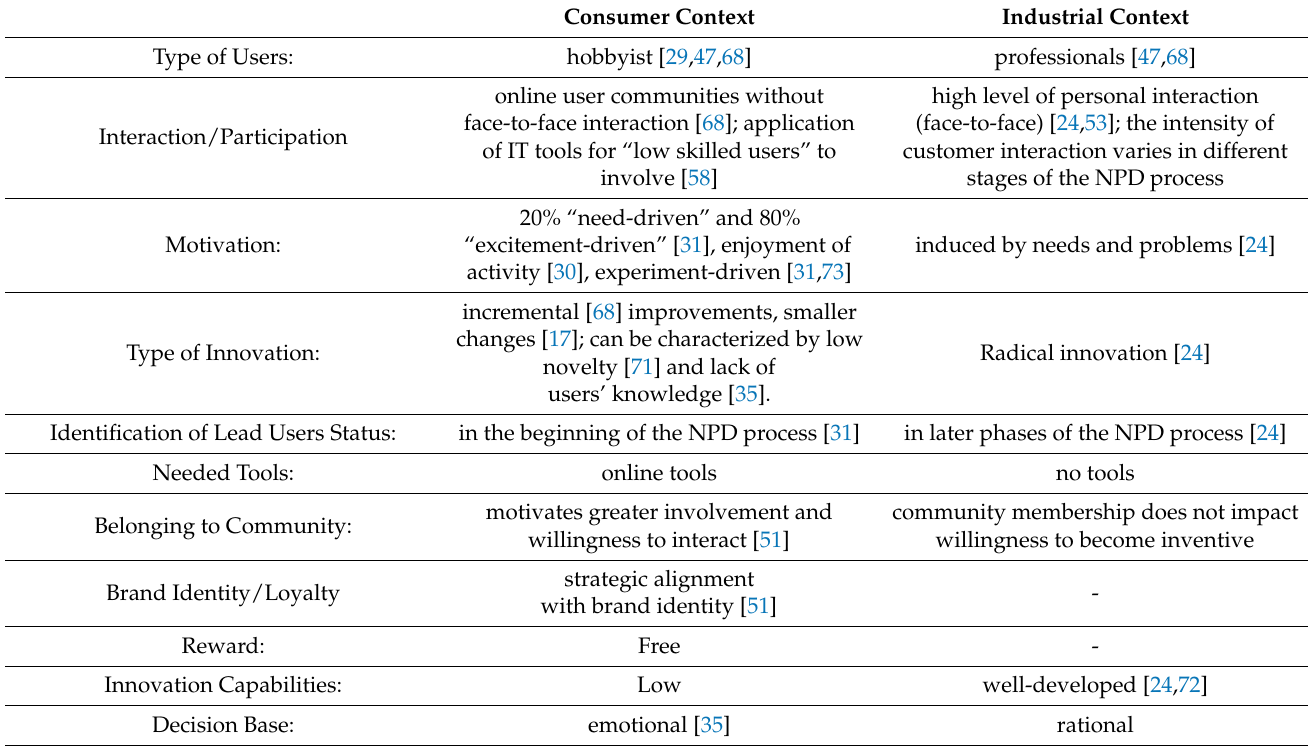
Table 8. Differences in the consumer and industrial